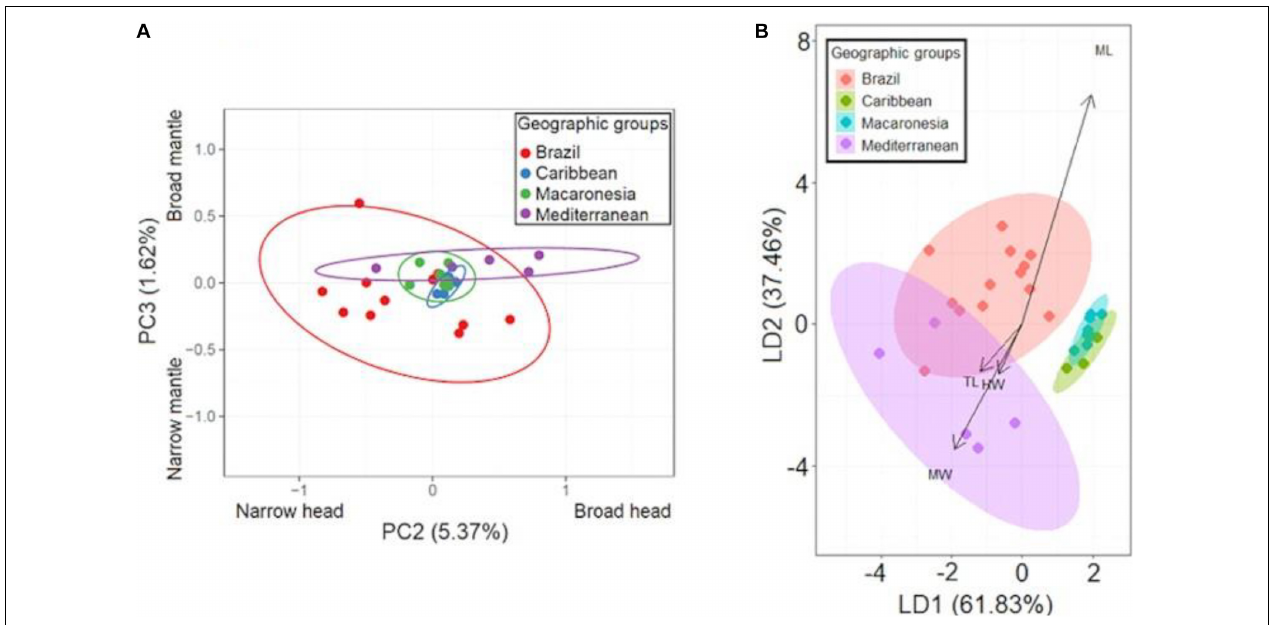
FIGURE 5 | Morphological variation between regional populations of Callistoctopus , including C. furvus and C. macropus . (A) Plot of individual scores of PC2 vs. PC3 depicting shape variation among geographic samples. (B) Size-free LDA plot depicting the degree of morphological separation among geographic samples. Prediction ellipses in both plots are such that with probability 0.95, a new observation from the same group will fall inside the ellipse.